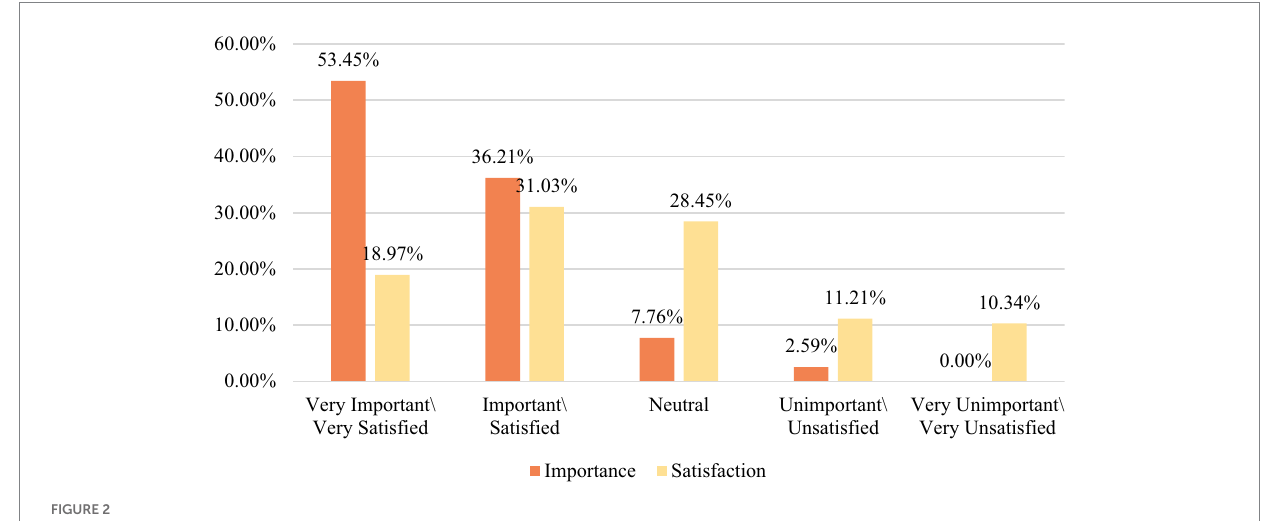
FIGURE 2 Significance and satisfaction level of the interactive feature of new media in public art